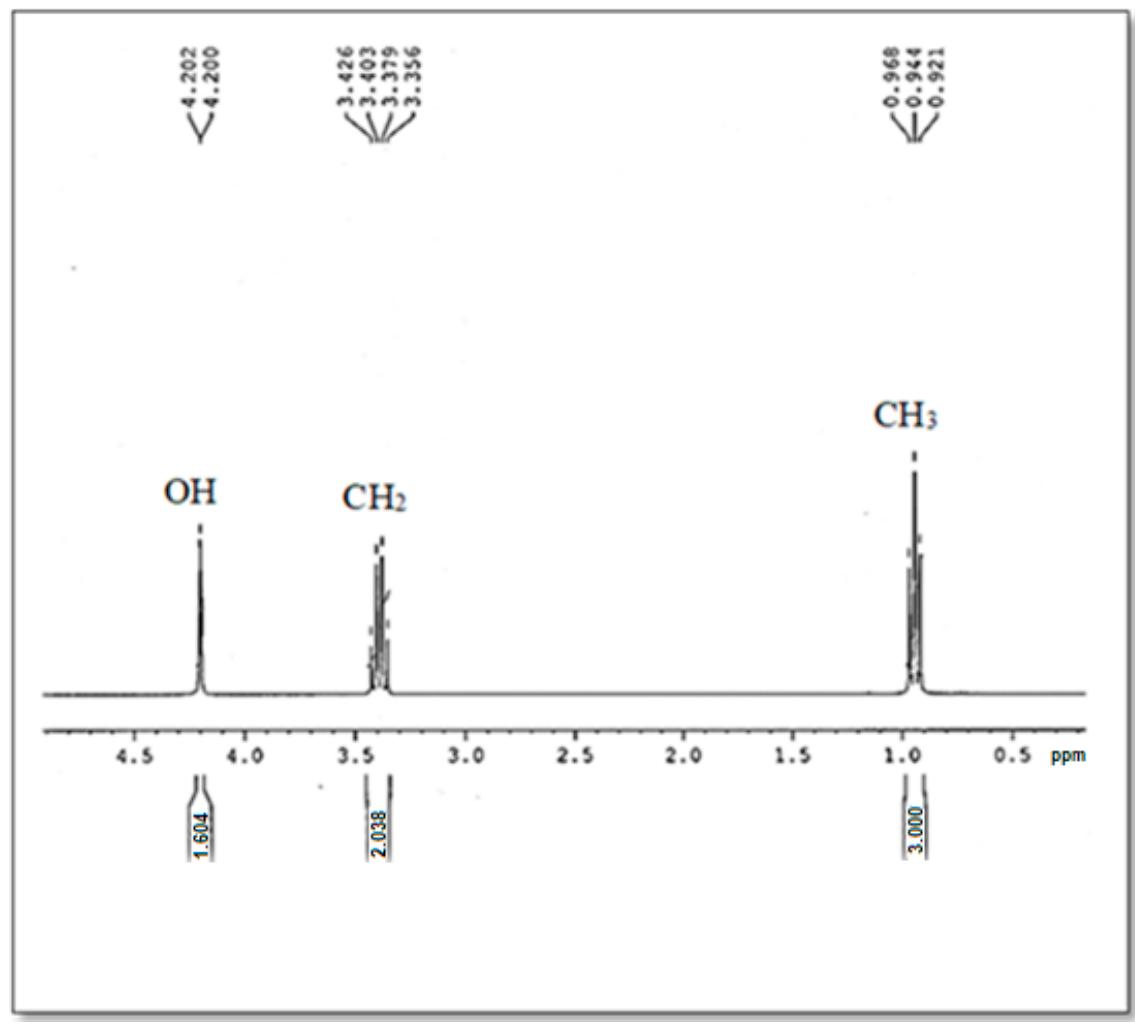
Figure 5. The 1H NMR Spectrum of the produced Bioethanol B15.